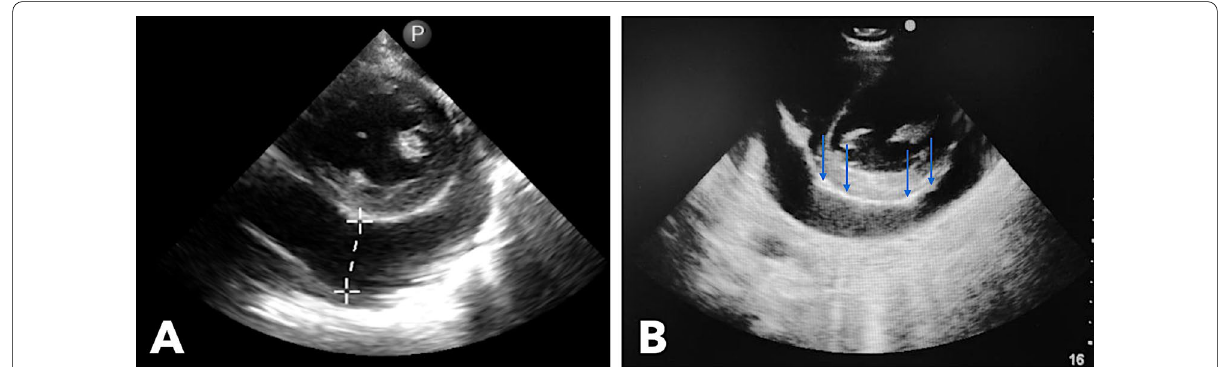
Fig. 3 Echocardiography performed showing 3.1‑cm echo‑free space in the posterior pericardial space ( A ) and thickened pericardium with frond‑like fibrinous projections (blue arrows) extending into the parietal pericardium ( B